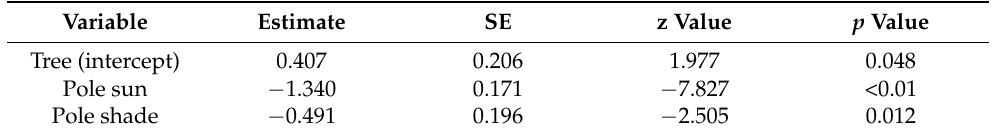
Table 1. Generalized linear mixed model testing the effect of nest type on probability of occupancy of barn owls breeding in nest boxes on trees, on poles in the shade, and on poles in sun. Variable